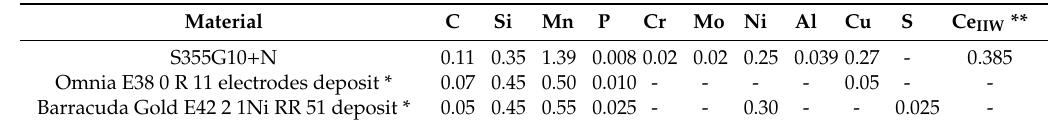
Table 1. Chemical compositions of used materials wt %.